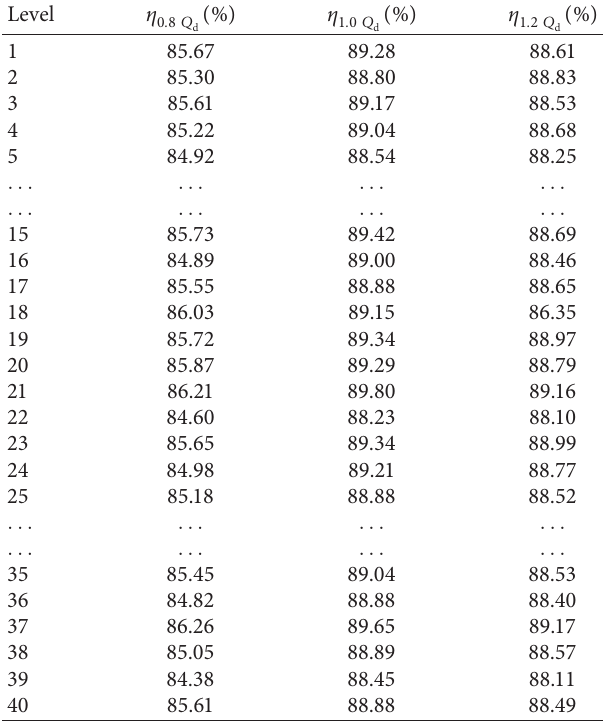
Table 7: LHS range of design parameters.